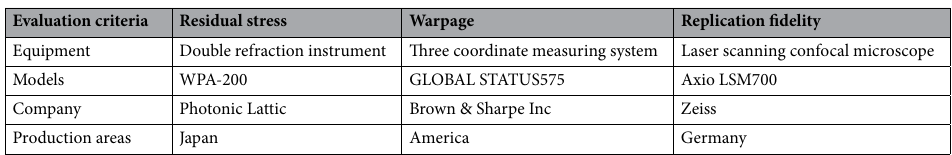
Table 4. The models of test equipment for protein electrophoresis microfluidic chip.